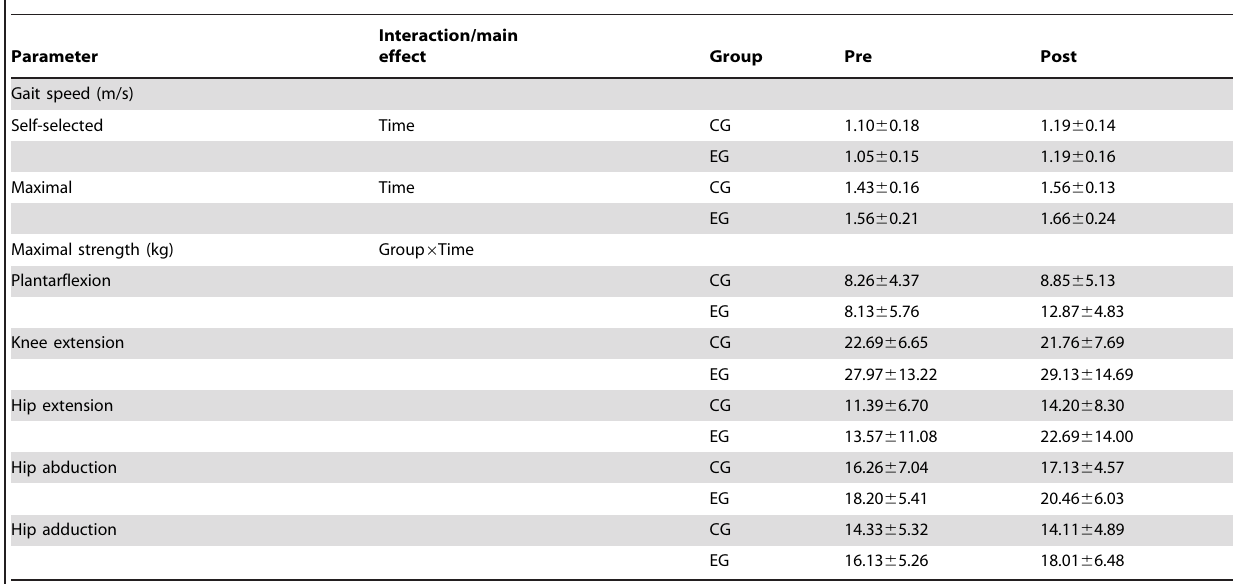
Table 1. Changes in the dependent